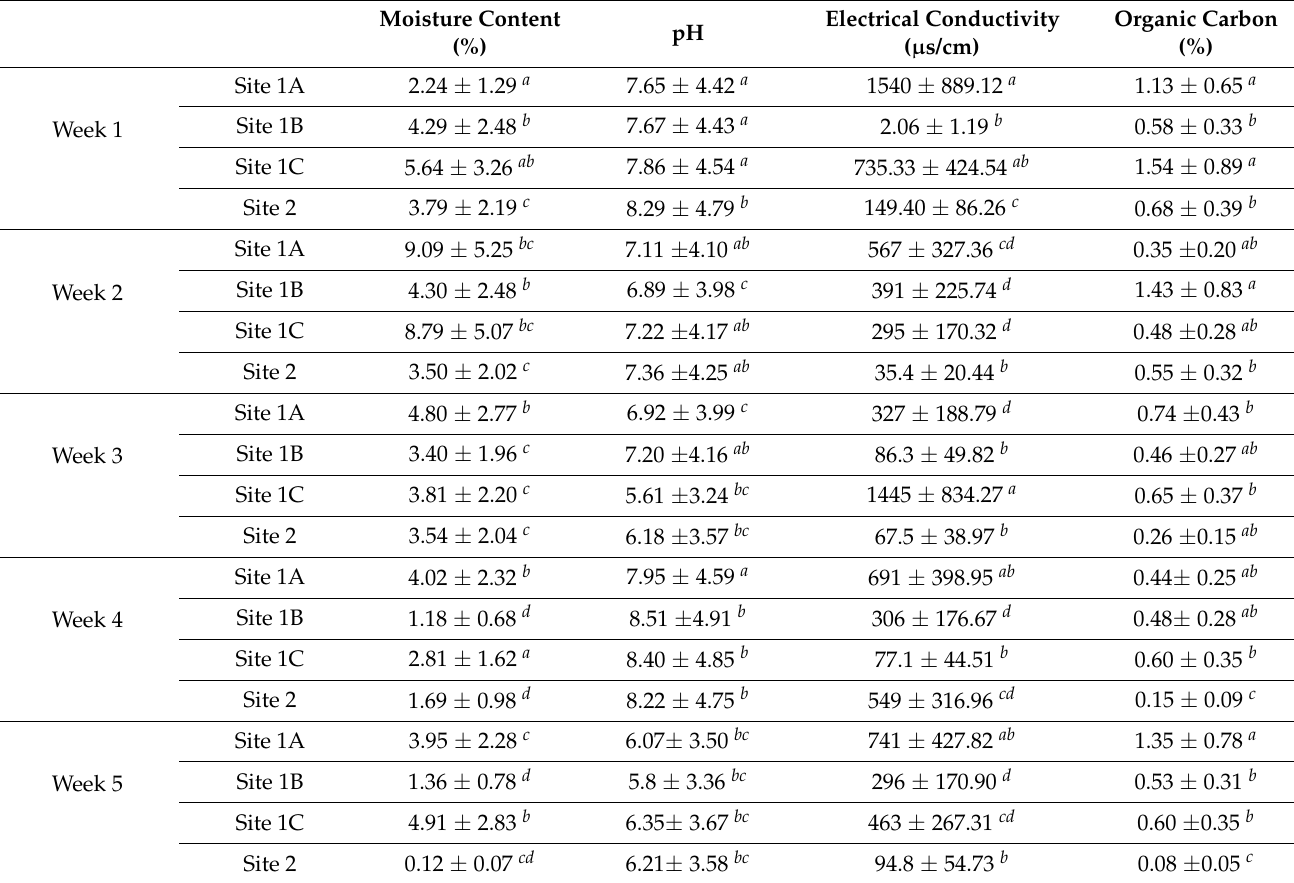
Table 1. Results of Physicochemical properties in soil samples. Moisture